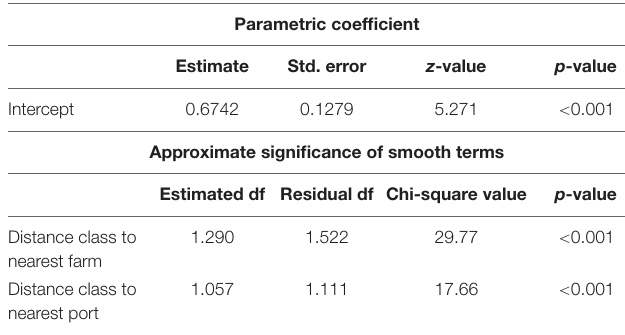
TABLE 3 | Results of generalized additive